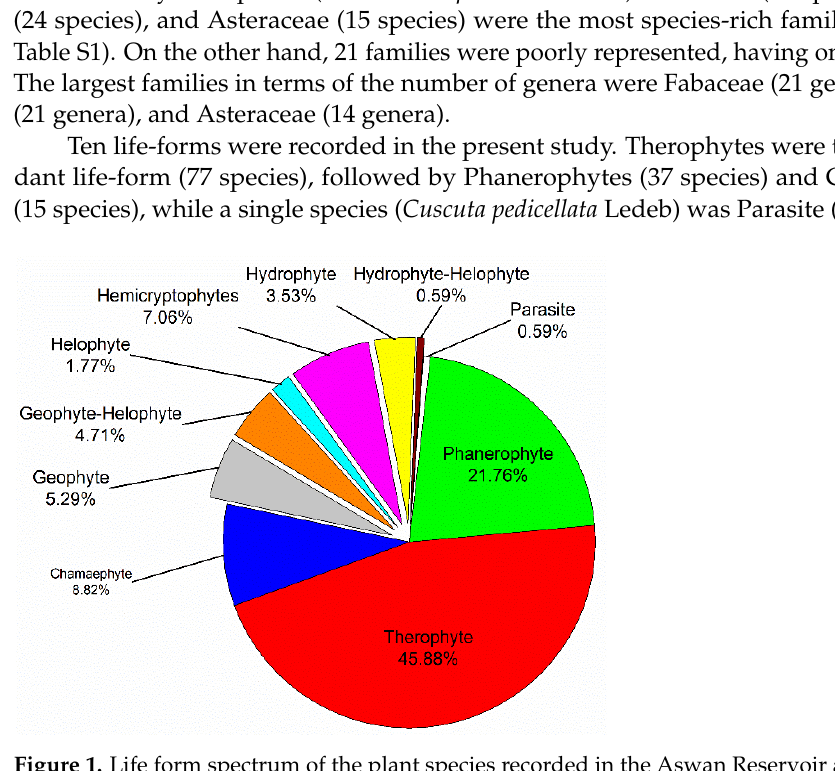
Figure 1. Life form spectrum of the plant species recorded in the Aswan Reservoir area.